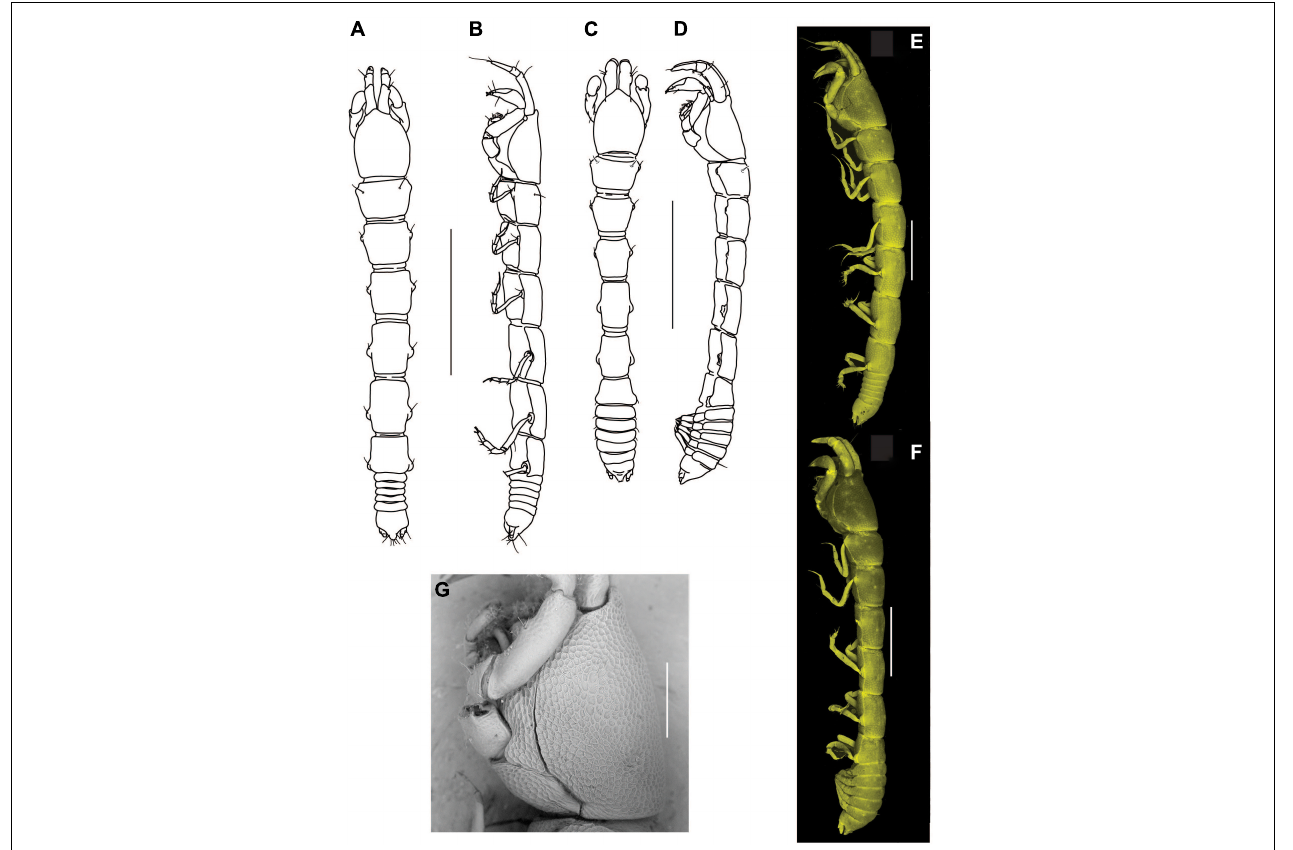
FIGURE 5 | Agathotanais frutosae n. sp., neuter, holotype ( A,B : NHM 58033), juvenile male, paratype ( C,D : ZMH K-61184), neuter, paratype ( E,G : ZMH K-61187), juvenile male, paratype ( F : ZMH K-61184). (A) dorsal view; (B) lateral view; (C) dorsal view; (D) lateral view; (E) lateral view (confocal picture); (F) lateral view (confocal picture); (G) pitted surface of body (SEM picture). Scale bars: (A–D) = 1 mm, (E–F) = 500 µ m, (G) = 200 µ